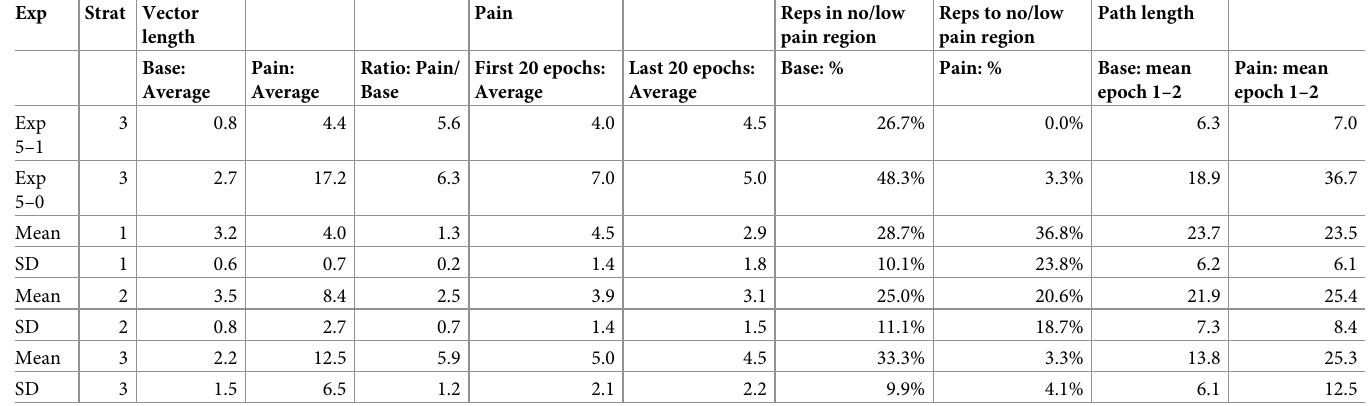
participants who adopted Strategy 1 did not change the average vector length, they used the experimentally-determined region with less/no noxious stimulation more frequently than par- ticipants who had a large change in vector length (Strategy 3) (one-way ANOVA (Strategy 1 vs. 2 vs. 3); F = 5.21, p = 0.013, η p2 = 0.30; post-hoc: p = 0.004) and a similar non-significant 2,24 tendency relative to those who used Strategy 2 (post-hoc: p = 0.062). Second, participants who adopted Strategy 3 had a greater initial sum of path length (i.e. greater variation in secondary plane) (quantified as mean epoch 1 and 2) of the Experimental (25.3(7.9)deg) than Baseline (13.8(6.2)deg) block (repeated-measures ANOVA; Block (Experimental vs. Baseline; repeated measure); Strategy (1 vs. 2 vs. 3; between-subject factor; Interaction—Block × Strategy F 5.25 P = 0.013, η p2 = 0.30; post hoc: P = 0.0002). An additional observation was that the group who adopted Strategy 3 had lower initial sum of path length (Baseline Strategy 3 = 13.8(6.2) deg) than the participants who adopted the other Strategies (Baseline Strategy 1 = 23.7(4.4) deg; Strategy 2 = 21.9(4.0)deg)(both: post hoc: P > 0.05). The frequency of exposure to the tar- get region with less noxious input was similar for all Strategy subgroups (Strategy 1–29(10)%; Strategy 2–25(11)%; Strategy 1–33(10)%; one-way ANOVA (Strategy 1 vs. 2 vs. 3); F p = 0.33, η p2 =